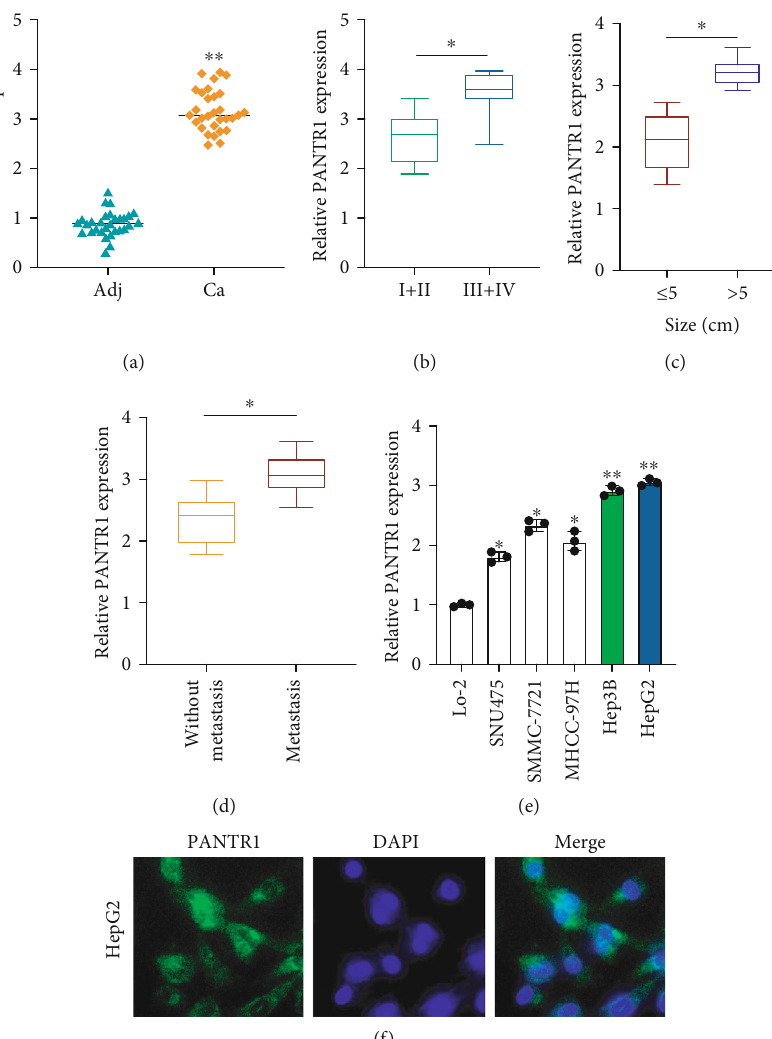
Figure 1: Expression of PANTR1 in HCC tissues and cells. (a) Relative expression of PANTR1 in HCC tissues was measured by qRT-PCR assay. (b) Expression level of PANTR1 in stage I-II and stage II-IV HCC tumors were assessed by qRT-PCR assay. (c) PANTR1 expression in di ff erent tumor sizes was measured by qRT-PCR. (d) PANTR1 expression in HCC tumors with or without metastasis status was measured by qRT-PCR, respectively. (e) The expression of PANTR1 in di ff erent HCC cell lines (SNU475, SMMC-7721, MHCC-97H, Hep3B, and HepG2) and normal liver cell LO-2 were detected by qRT-PCR. (f) FISH assay was conducted to determine the location of PANTR1 in HepG2 cells. Scale bar for FISH images: 10 μ m. All assays were repeated three times. ∗ P < 0 : 05 and ∗∗ P < 0 : 01